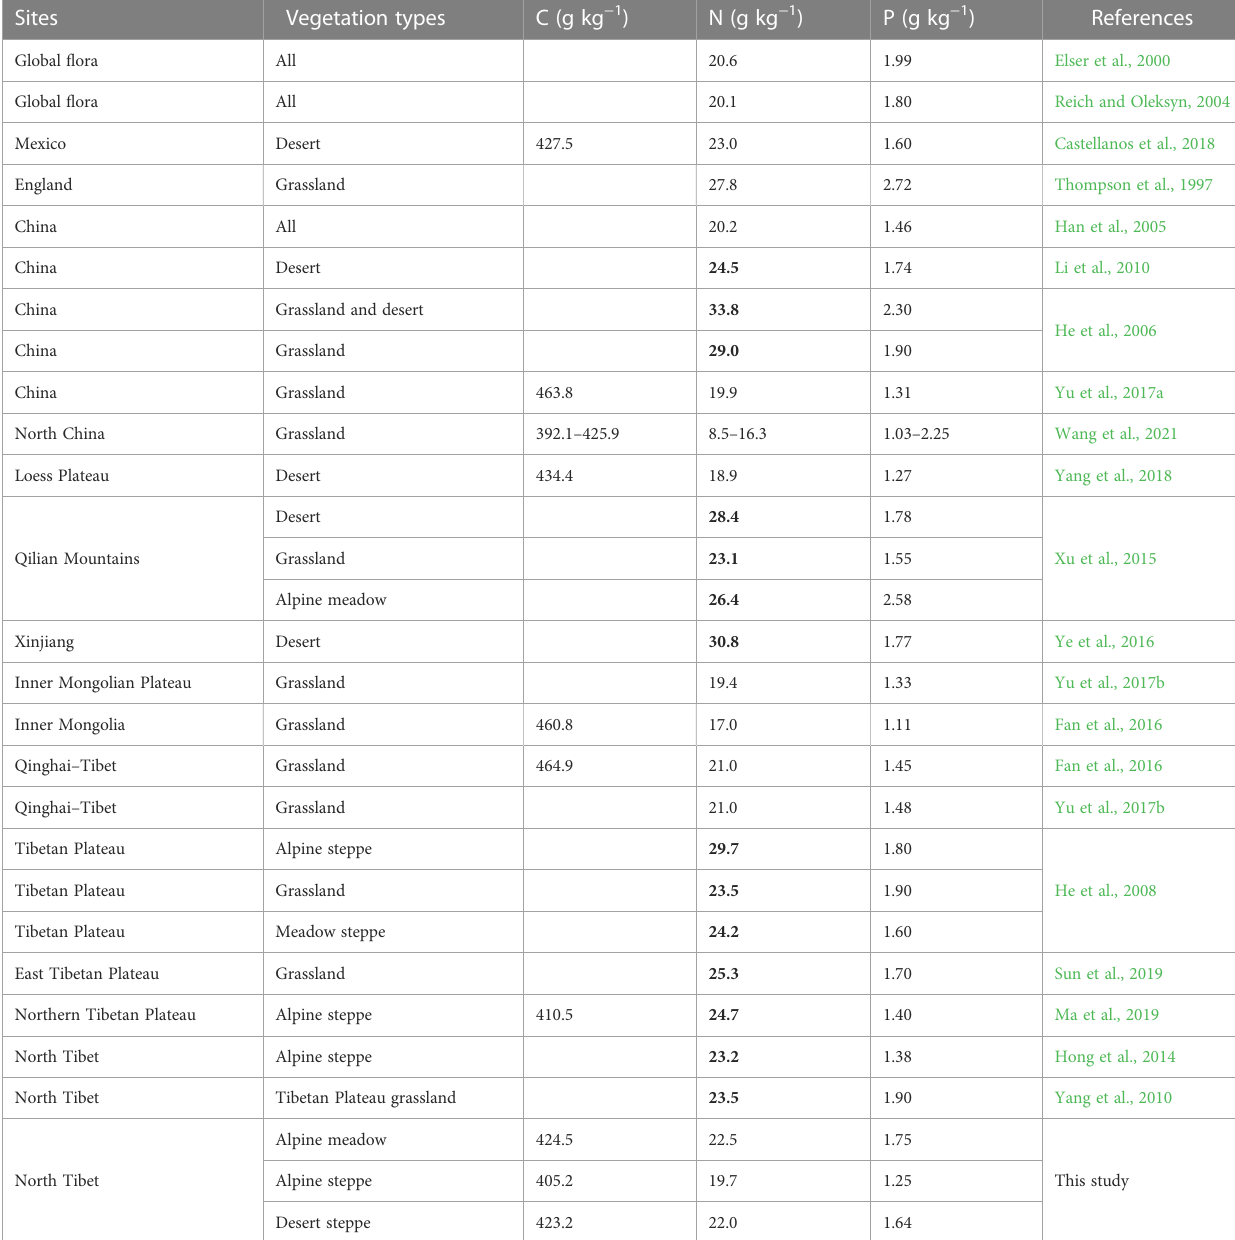
TABLE 2 Comparison of foliar C, N, and P concentrations among different